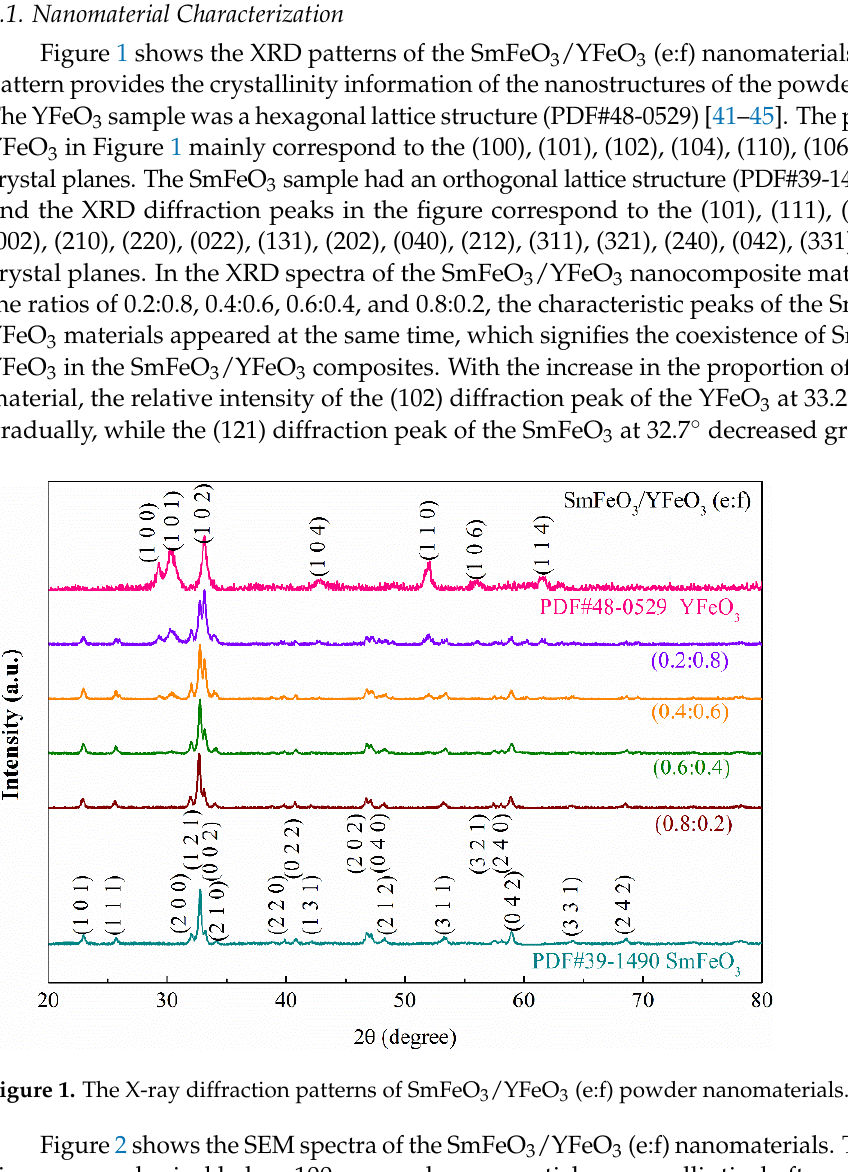
3 /YFeO 3 (e:f) powder